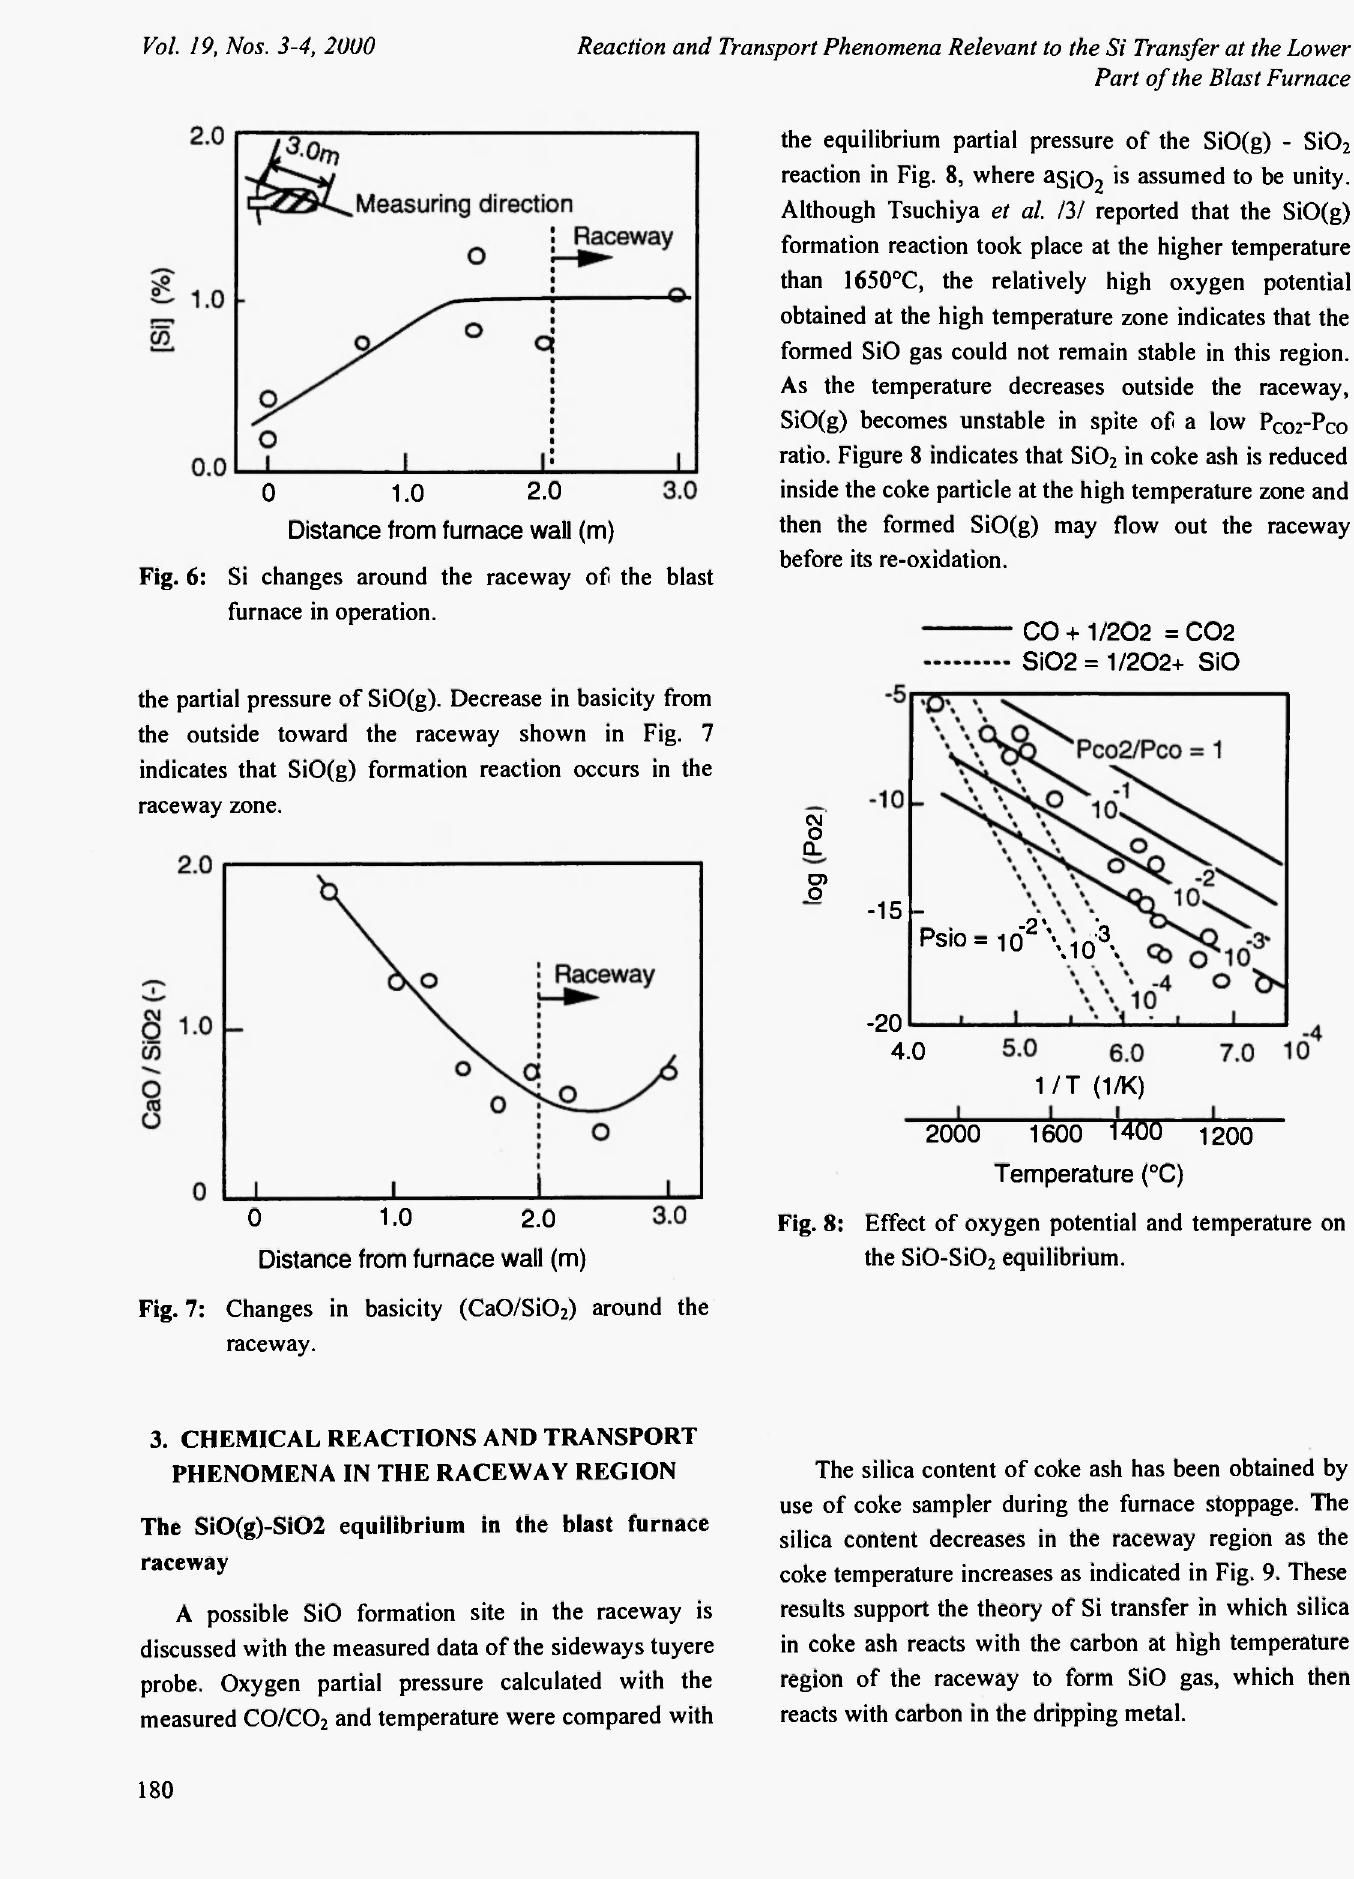
Fig. 6: Si changes around the raceway of the blast furnace in operation.